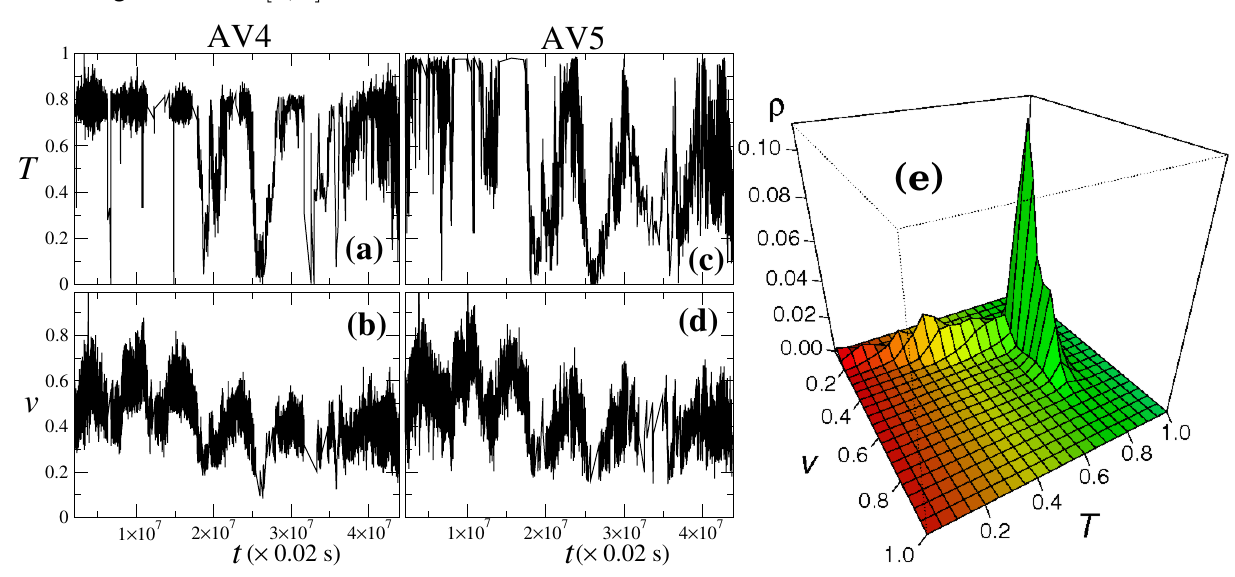
Figure 3. The torque and wind speed measured at Turbines AV4 and AV5 from Senvion at the Alpha Ventus wind farm. All data were masked through normalization to the largest values (see the text). For constructing the stochastic model, one uses ( a ) the torque T and ( b ) the wind speed v at AV4 for estimating ( c ) the torque at AV5 conditioned to its ( d ) wind speed. In ( e ), we show the histogram of the observed pair of measurements, torque and wind velocity, measurements taken at Turbine AV4. In both T and v , 21 bins were used in the full range of values [0 , 1]